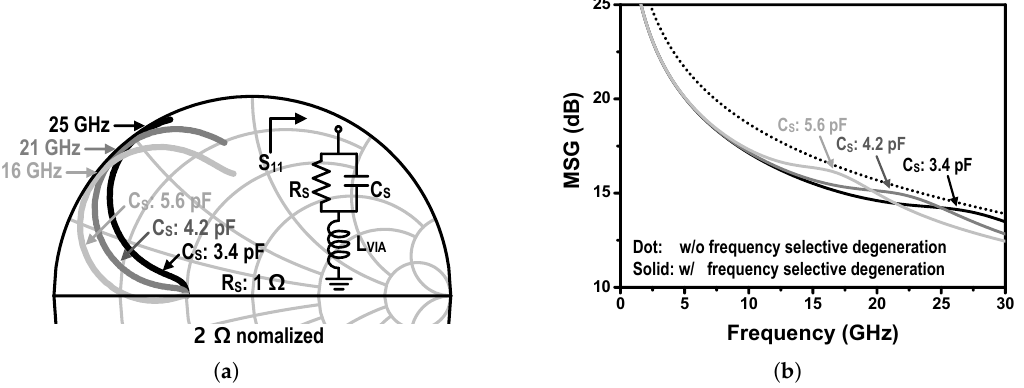
Figure 2. Frequency characteristics according to the capacitor values with a resistance of 2 Ω , ( a ) S11 for the frequency selective degeneration circuit, ( b ) maximum stable gain (MSG) of the transistor.